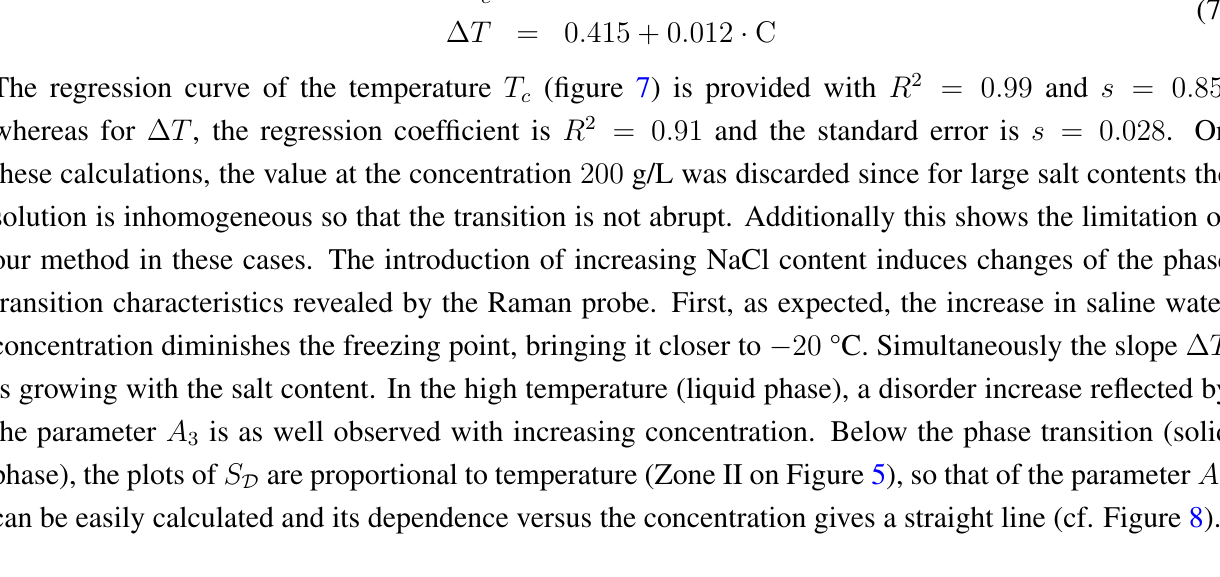
and ∆ T with the concentration. c